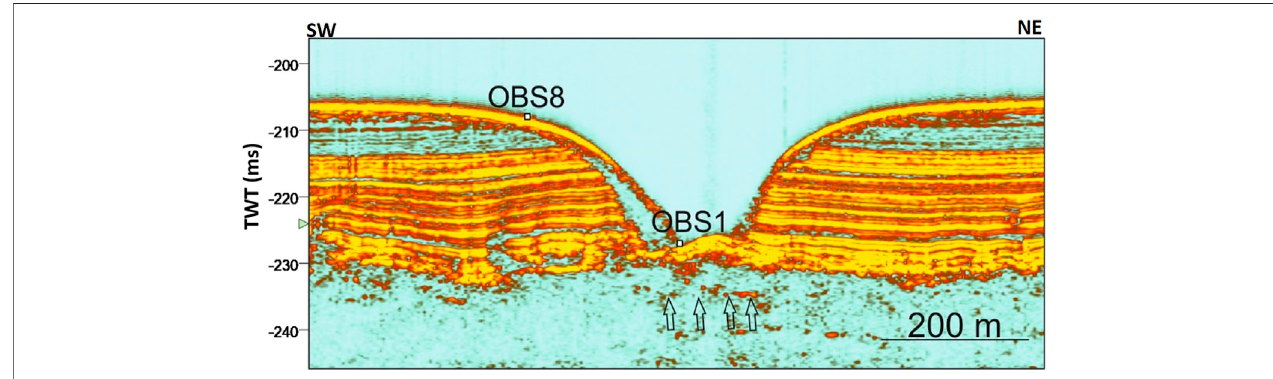
FIGURE 13 | SBP data sampling the locations ofthe OBS1 and 8. The white squares are OBS 1 and 8. The lowamplitude re fl ector is shown in black arrows. TWT values here are milliseconds below the sea surface.